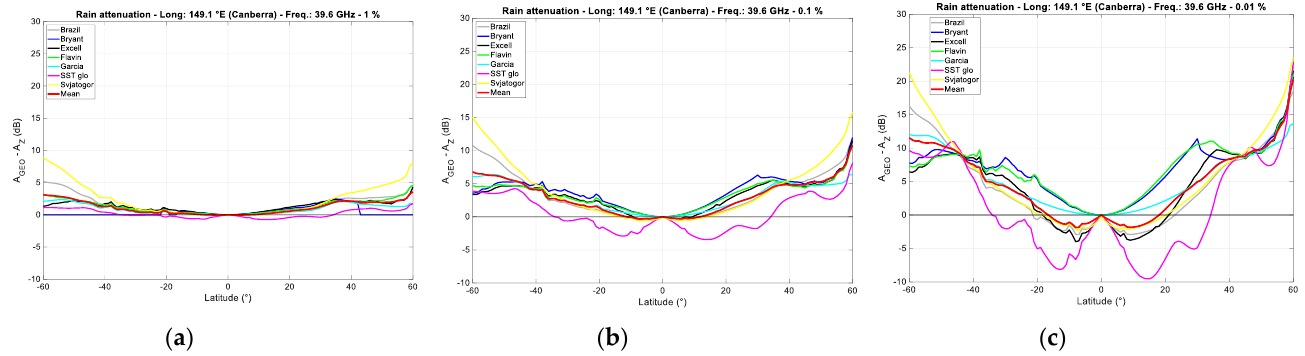
Figure 7. The difference A GEO − A Z , calculated at fixed annual probabilities 1% ( a ), 0.1% ( b ), and 0.01% ( c ), between the rain attenuation exceed in the GEO path, A GEO , and the rain attenuation exceed in the GeoSurf path, A Z , i.e., at the zenith in Pasadena; 39.6 GHz, circular polarization.